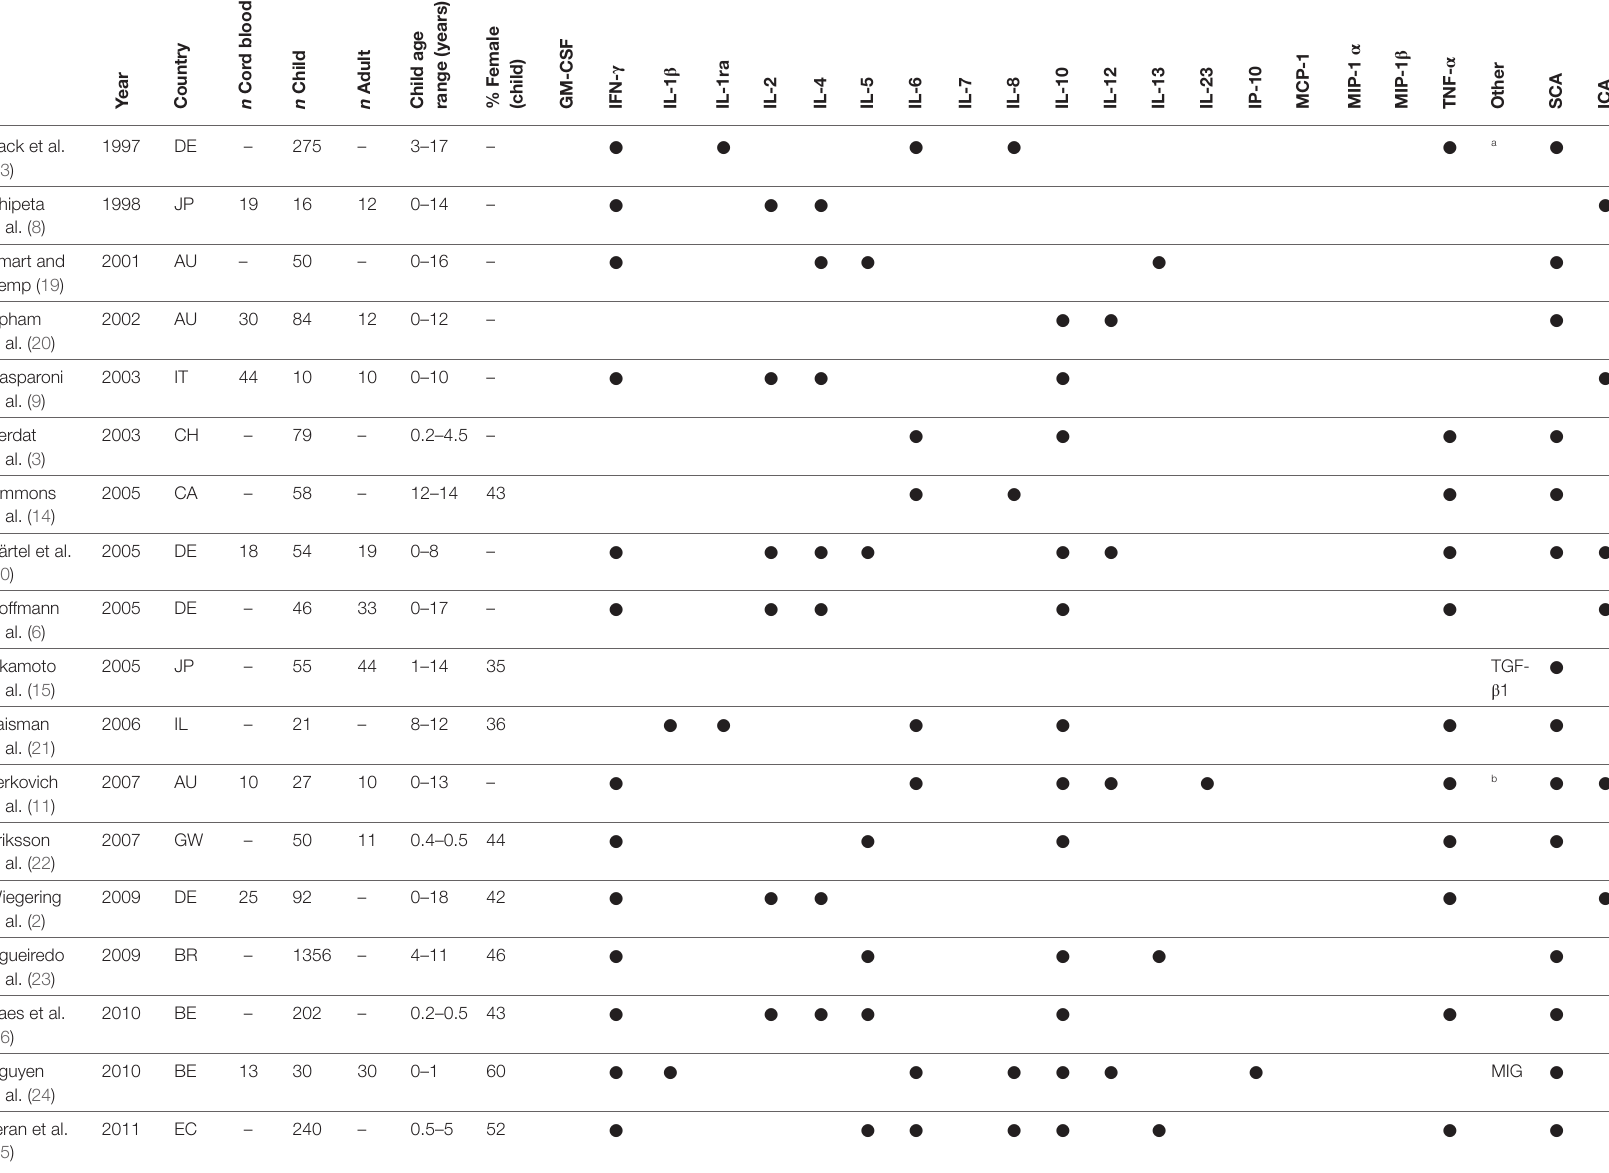
taBLe 1 | Studies included in final analysis with baseline characteristics, cytokines analyzed and method chosen for